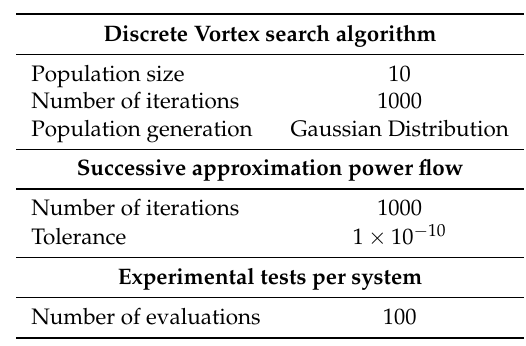
Table 2. Parameters for implementing the proposed DVSA